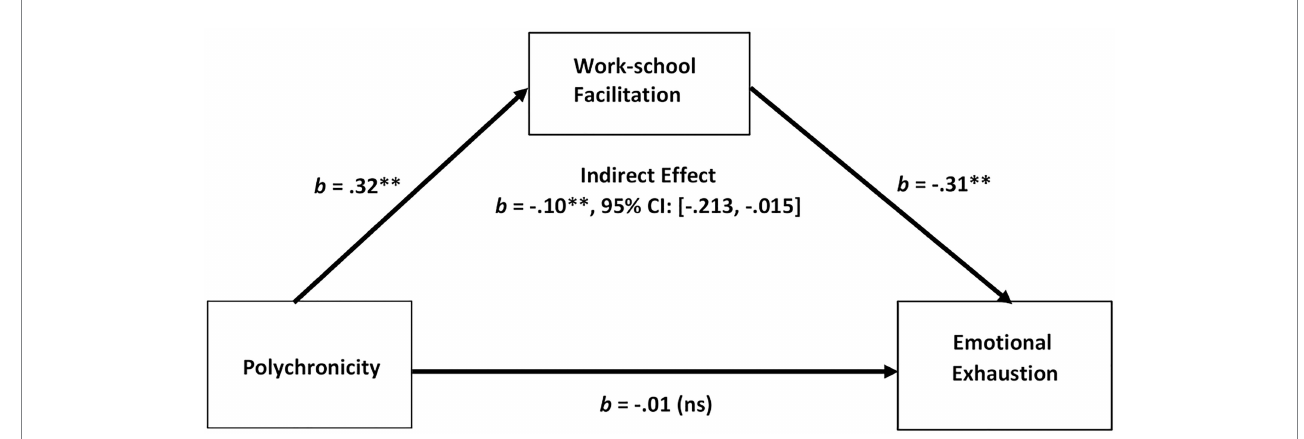
FIGURE 1 Mediation model outlining the relationship between polychronicity and emotional exhaustion. ** p <